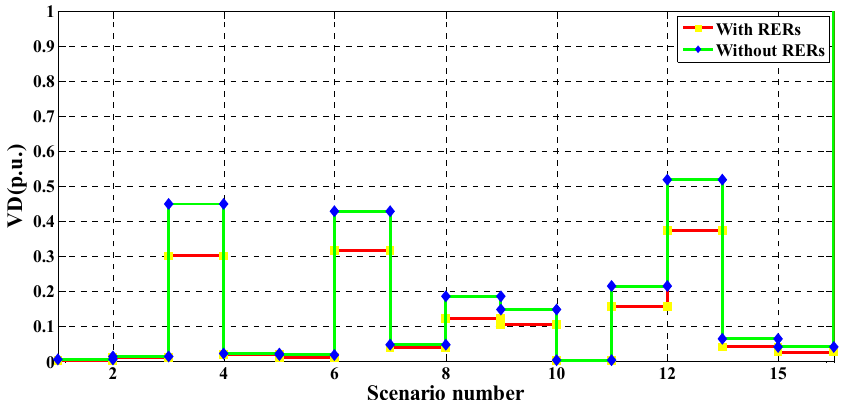
Figure 9. The IEEE 118-bus system emissions.